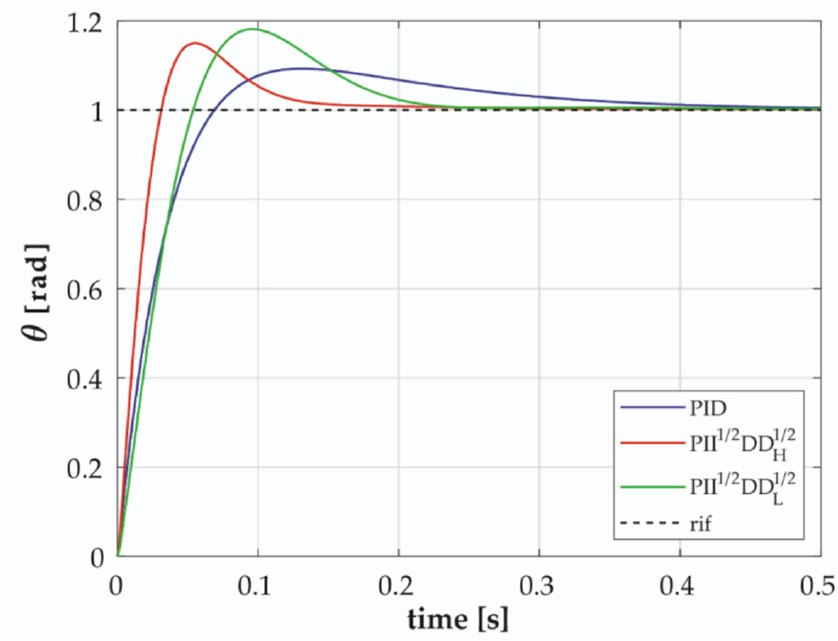
Figure 7. Comparison of the unit step responses of the closed-loop systems: PID (blue); PII 1/2 DD 1/2 H (red); PII 1/2 DD 1/2 L (green).